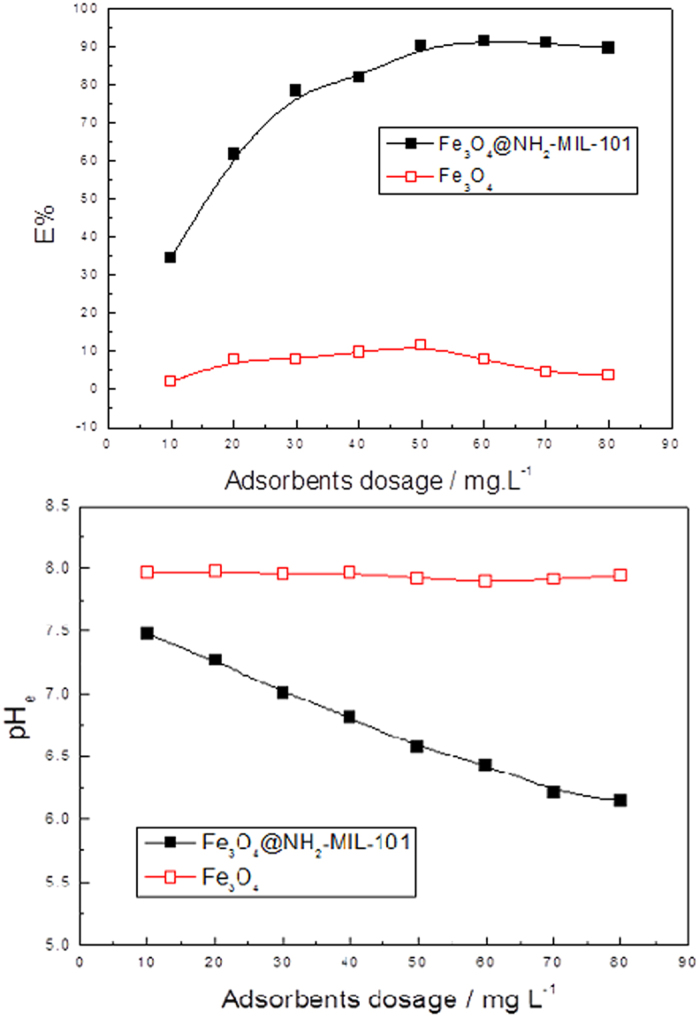
(a) Effects of the adsorbent dosage on the removal efficiency E%. (b) pHe by Fe3O4@NH2-MIL-101(Fe). (Fe3O4@NH2-MIL-101(Fe), 2–16 mg; NaH2PO4 c0 = 0.6 mgL−1; V = 0.2 L; T = 293 K).